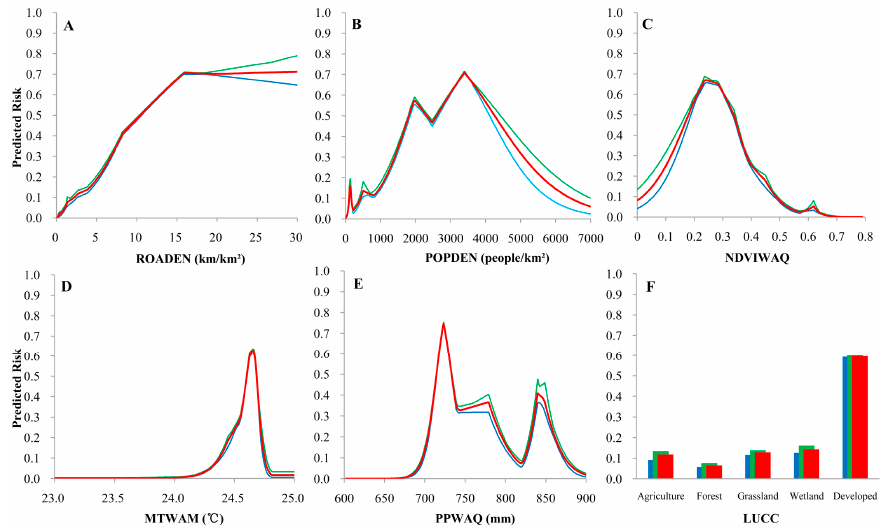
Figure 4. Response curves for the variables in model C as related to the predicted risk of Dengue Fever outbreak. Red line/bar indicates the mean values for the 10 Maxent runs; green line/bar indicates the maximum values; and blue line/bar indicates the minimum value. ( A ) road density; ( B ) population density; ( C ) normalized difference vegetation index (NDVI) of the warmest quarter; ( D ) mean temperature of the warmest month; ( E ) precipitation of the warmest quarter; ( F ) land use and land cover change